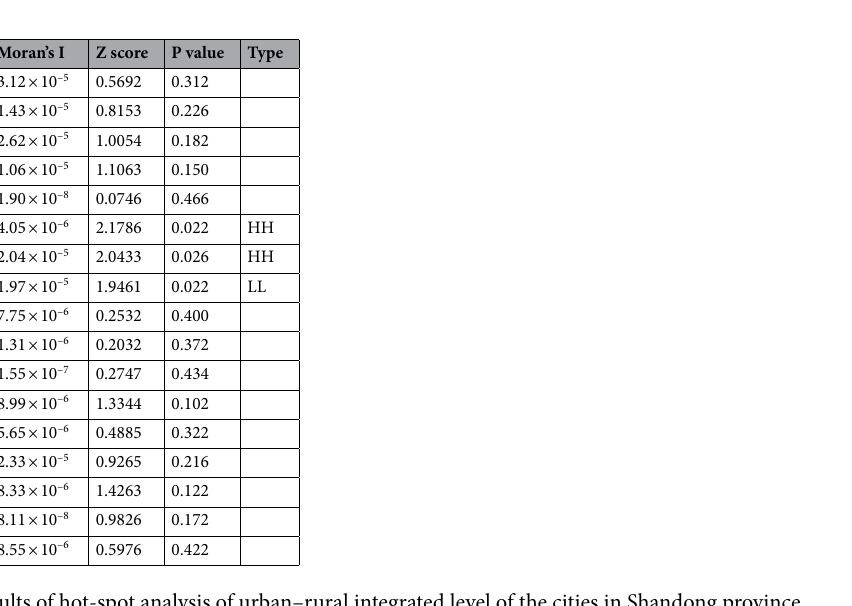
Table 2. Results of hot-spot analysis of urban–rural integrated level of the cities in Shandong province.